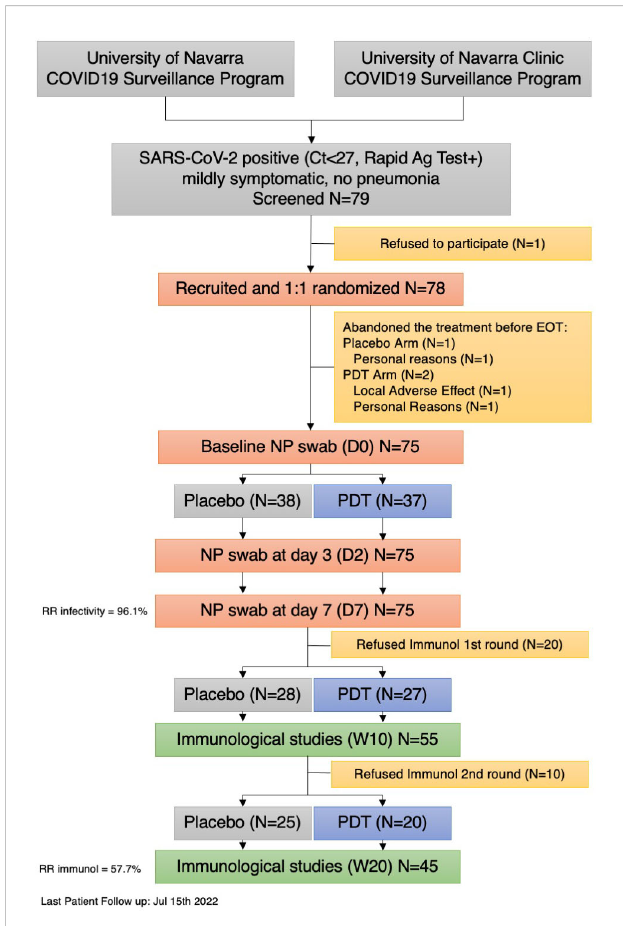
FIGURE 1 Flow Chart of patient recruitment. RR , Retention Rate Rate; PDT , Photodynamic Treatment; Ag, Antigen; EOT, End of Treatment; D,Day; W,